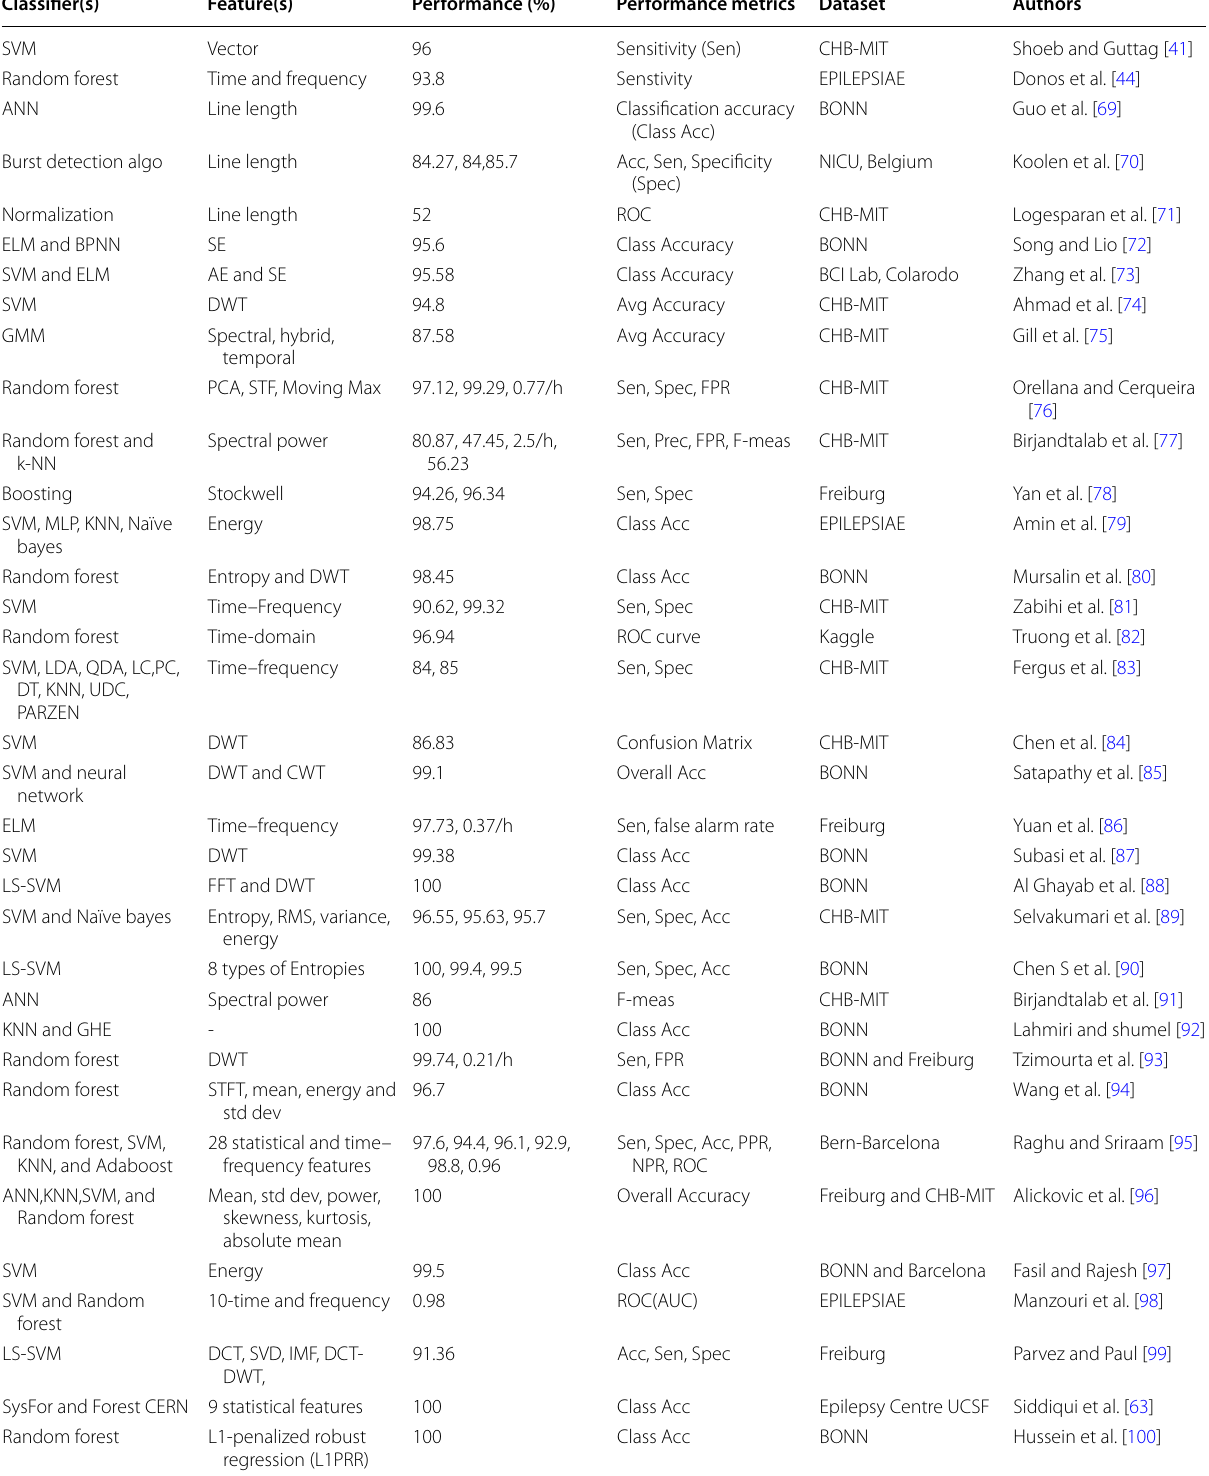
Table 3 Overview of existing work on seizure detection using—machine learning classifiers, features, performance score, performance metrics, datasets, and